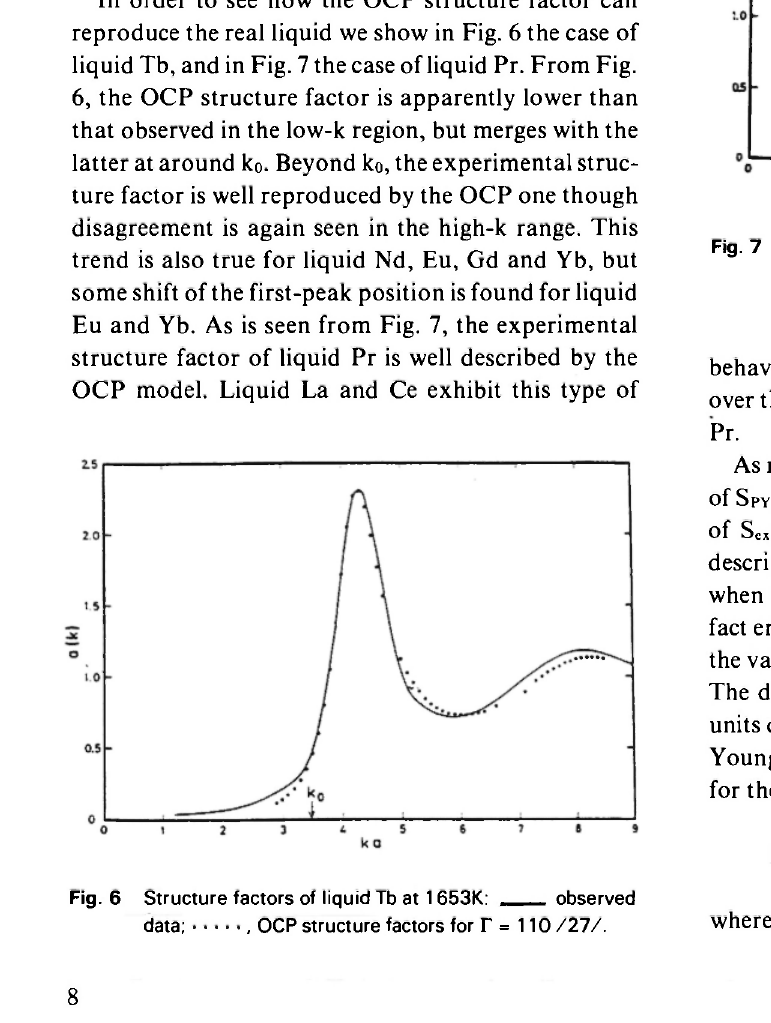
Fig. 6 Structure factors of liquid Tb at 1653K: _ __ observed data; , OCP structure factors for Γ = 110 /27/.